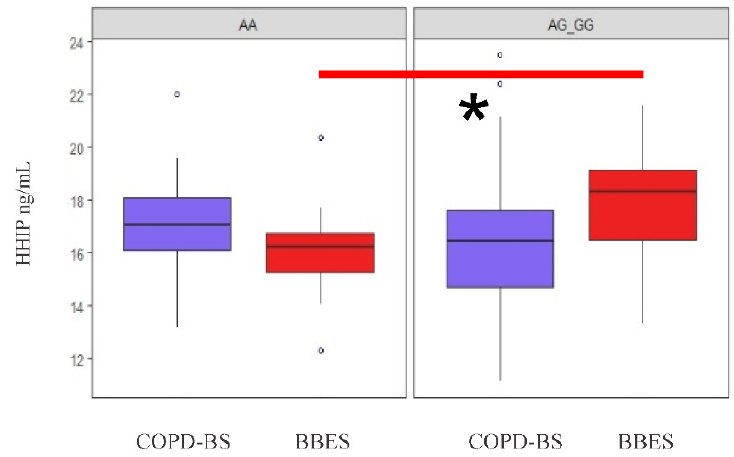
Figure 3. Levels of HHIP protein in serum by the dominant model of rs13118928. * The statistical difference between BBES with AA vs. AG+GG ( p < 0.05).